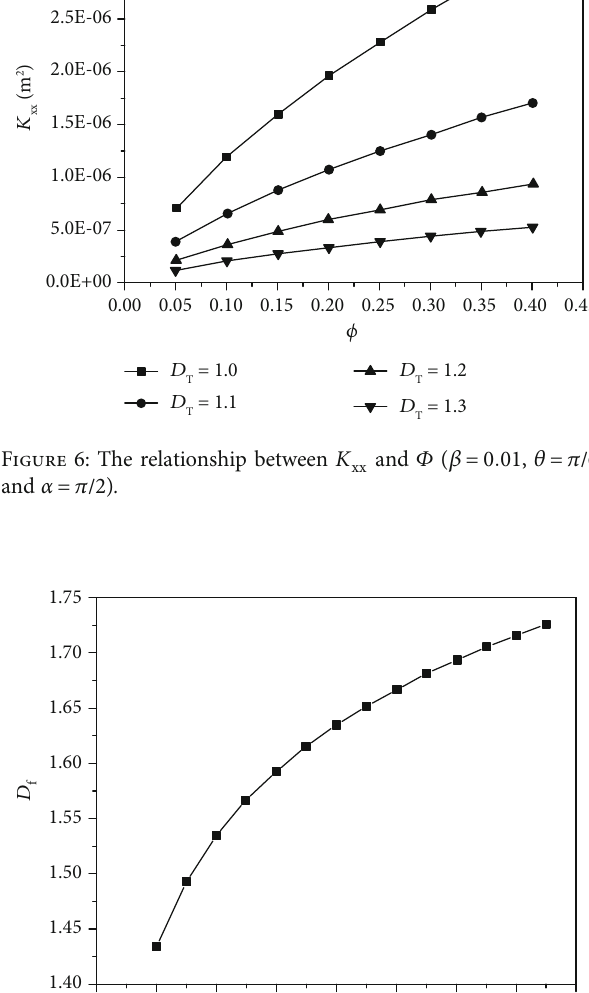
Figure 7: The relationship between Φ and D